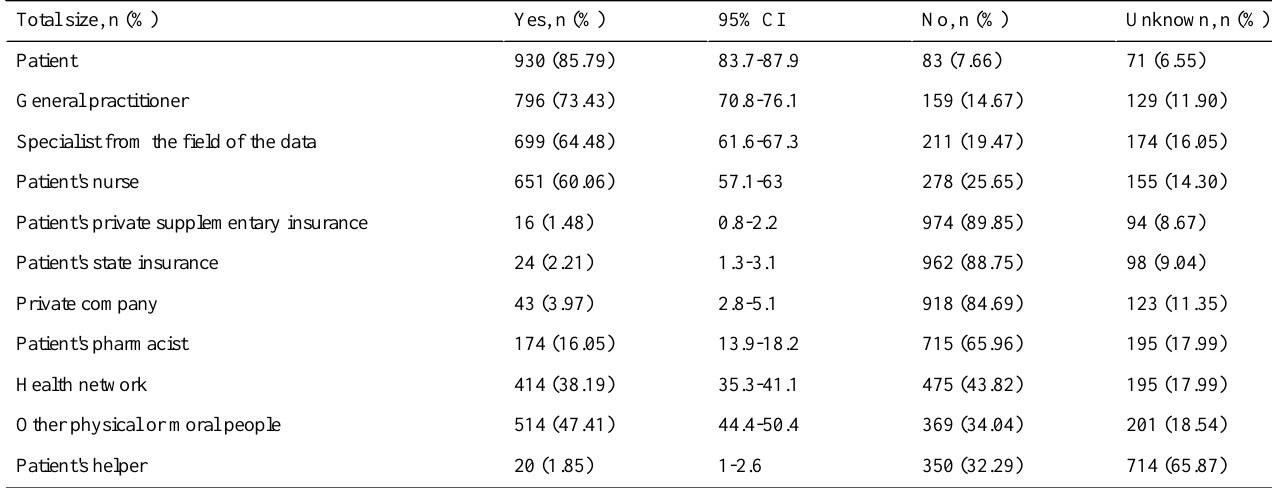
Table 4. Recipients of connected health devices (CHD)–generated data according to general practitioners (GPs;